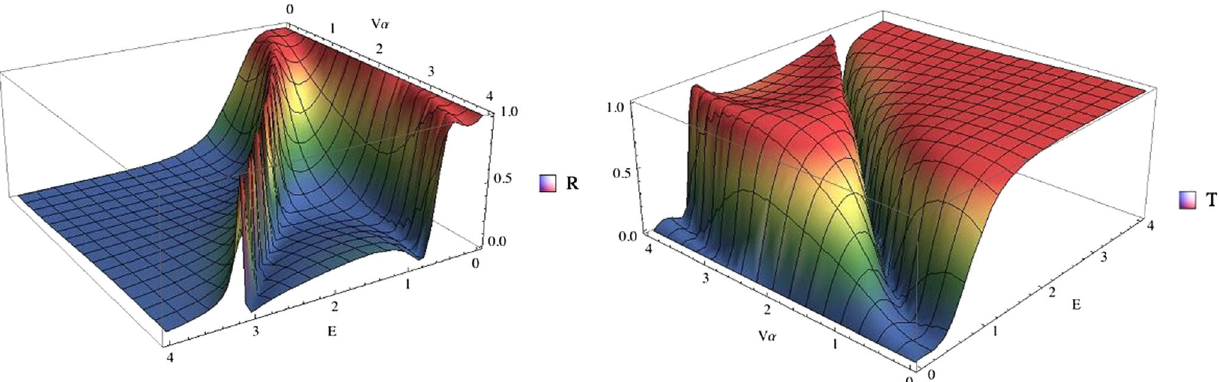
Fig. 7 Reflection and transmission coefficients versus energy and real part of the potential